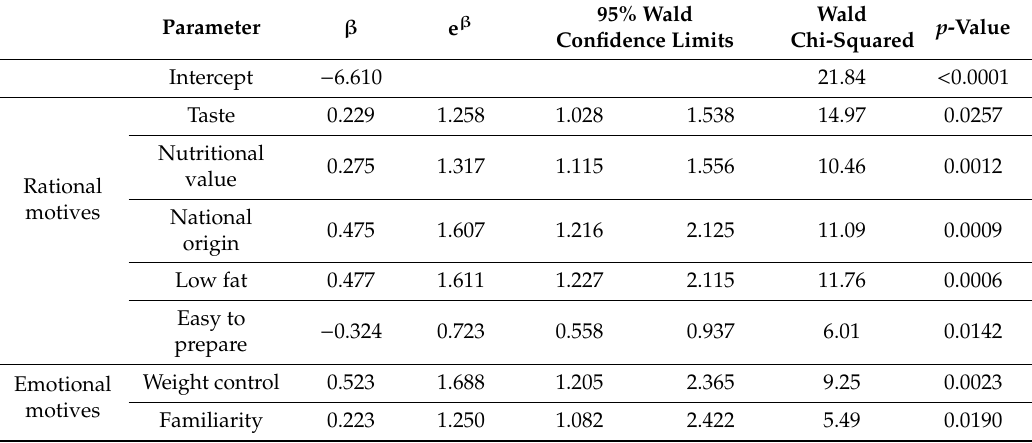
Table 5. Statistically significant variables and their estimation properties used to develop the logistic regression